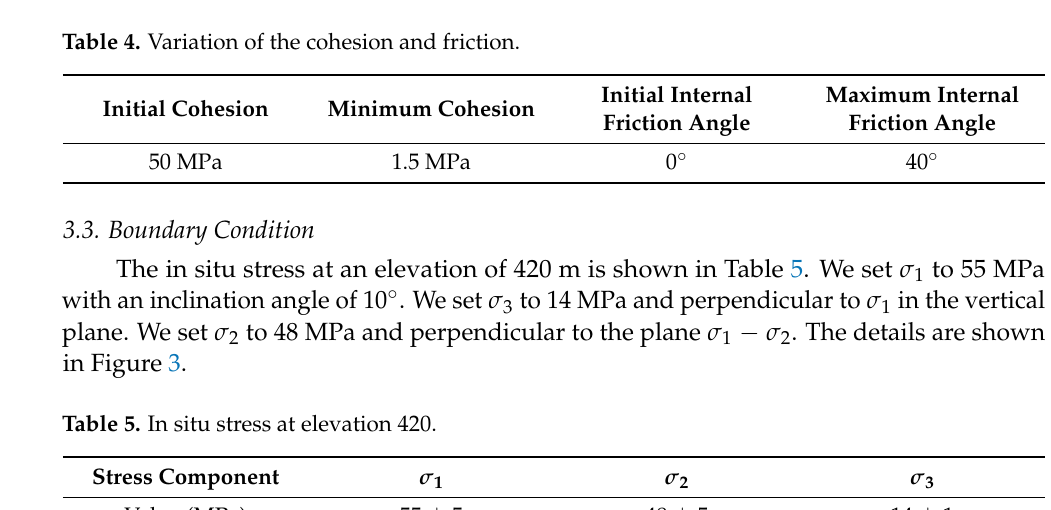
Figure 3. Direction of the stress.